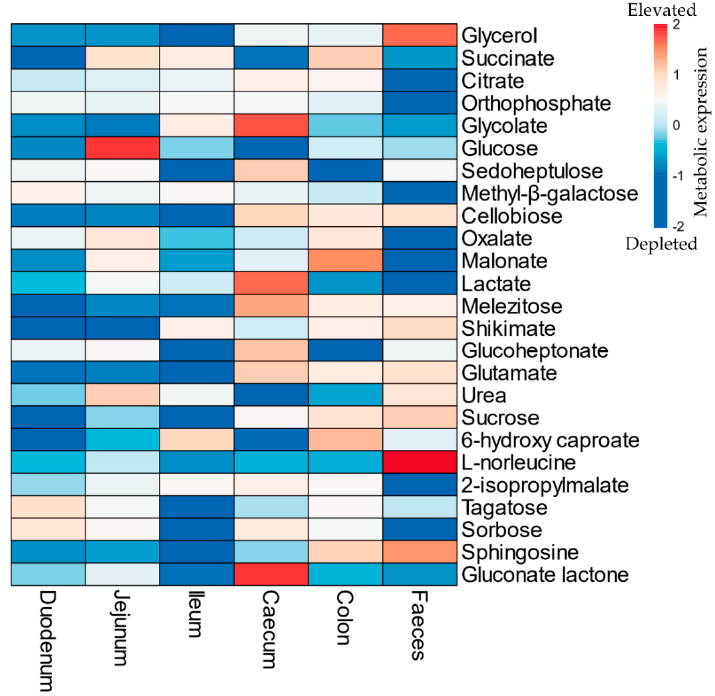
Figure 2. List of top 25 metabolites (in descending order) with significantly high variable importance in projection (VIP) scores in the mouse gut during Cryptosporidium infection. The colors refer to relative depletion (blue) and elevation (red) of the metabolites in the gut of infected mice with respect to the uninfected mice (Refer to Table S13 for data). Note: The scale indicates log transformed and pareto scaled values for the elevated (red) or depleted (blue) metabolites during the infection.